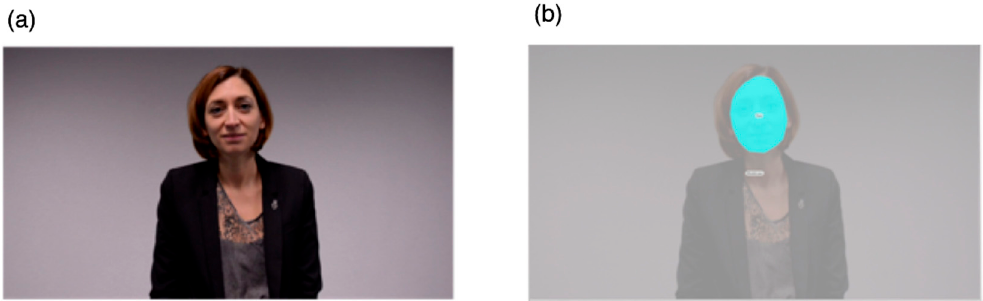
Figure 1. ( a ) Eye-tracking stimuli and ( b ) area of interest.